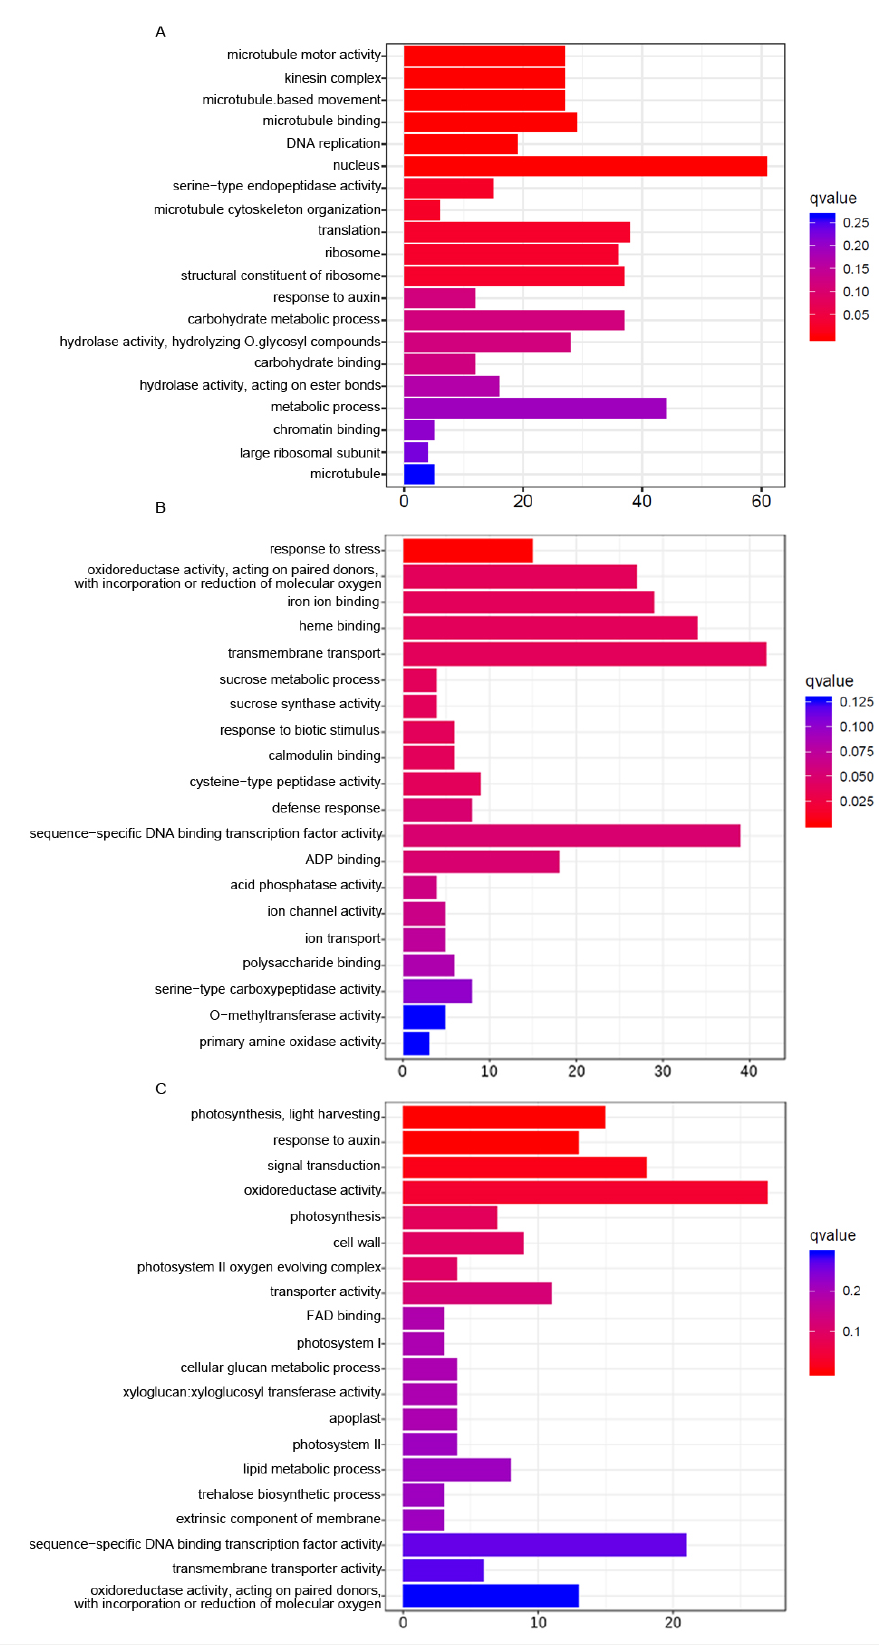
Figure 3 Enrichment of selected categories of GO biological processes in genes upregulated in 2 ( A ), 3 ( B ), and 4 ( C ) week NO leaves compared to the previous week. Functional annotation of upregulated genes into the biological process, cellular component, and molecular function categories within the gene ontology (GO)